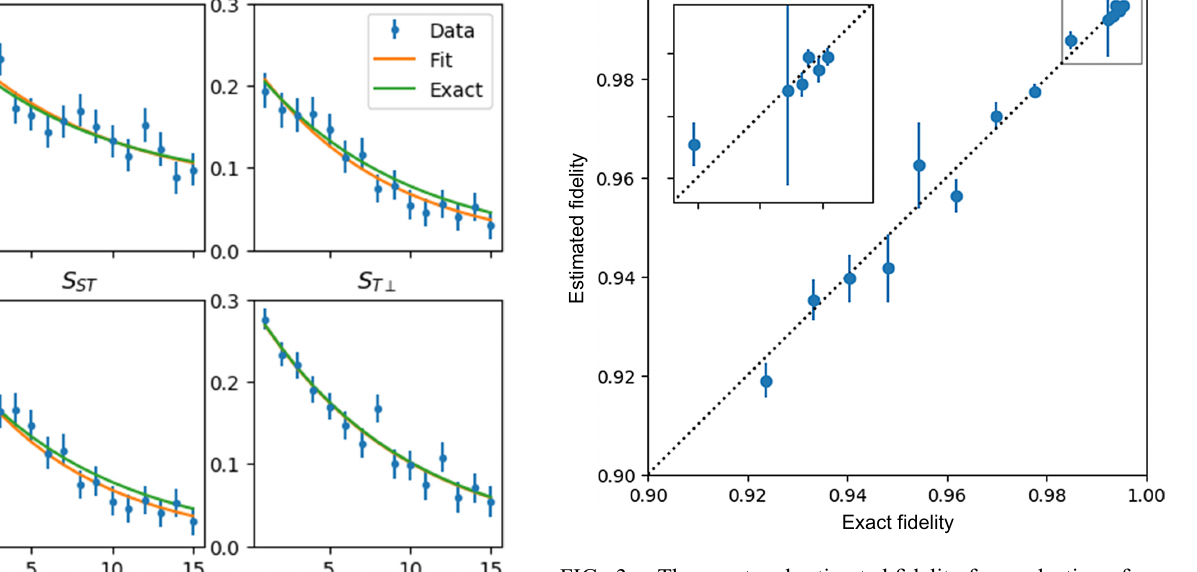
FIG. 3. The exact and estimated fidelity for a selection of ran- domly generated error channels. Each estimate is based on data taken over 15 different lengths N . Each estimate is arrived at by applying a total of 150 000 benchmarking group elements. This is the same number of elements applied in the experiment described in Ref. [23]. The diagonal line denotes the points where the exact and estimated fidelities are equal. The data agree with the line with a reduced χ 2 value of .9, indicating good agreement. Note that the error bars are derived from statistical uncertainty in the data, and vanish in the limit of an infinite number of data